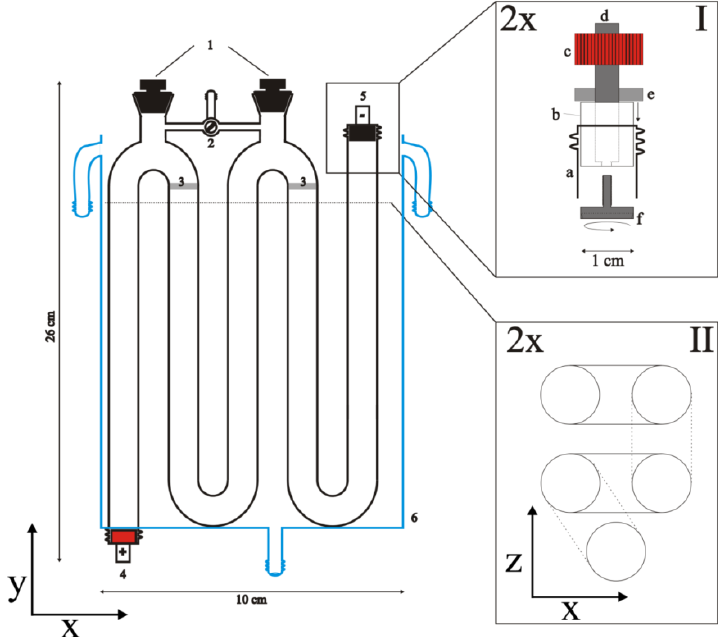
Figure 4. Hittorf cell: 1 : NS 14 ground glass joint; 2 : three-way valve for inert gas flooding; 3 : glass frit G 1; 4 : anode; 5 : cathode; 6 : thermostat housing; a : glass tube; b : bushing (Teflon); c : screw cap; d : banana jack; e : O-ring sealing (Teflon); f : stainless steel electrode